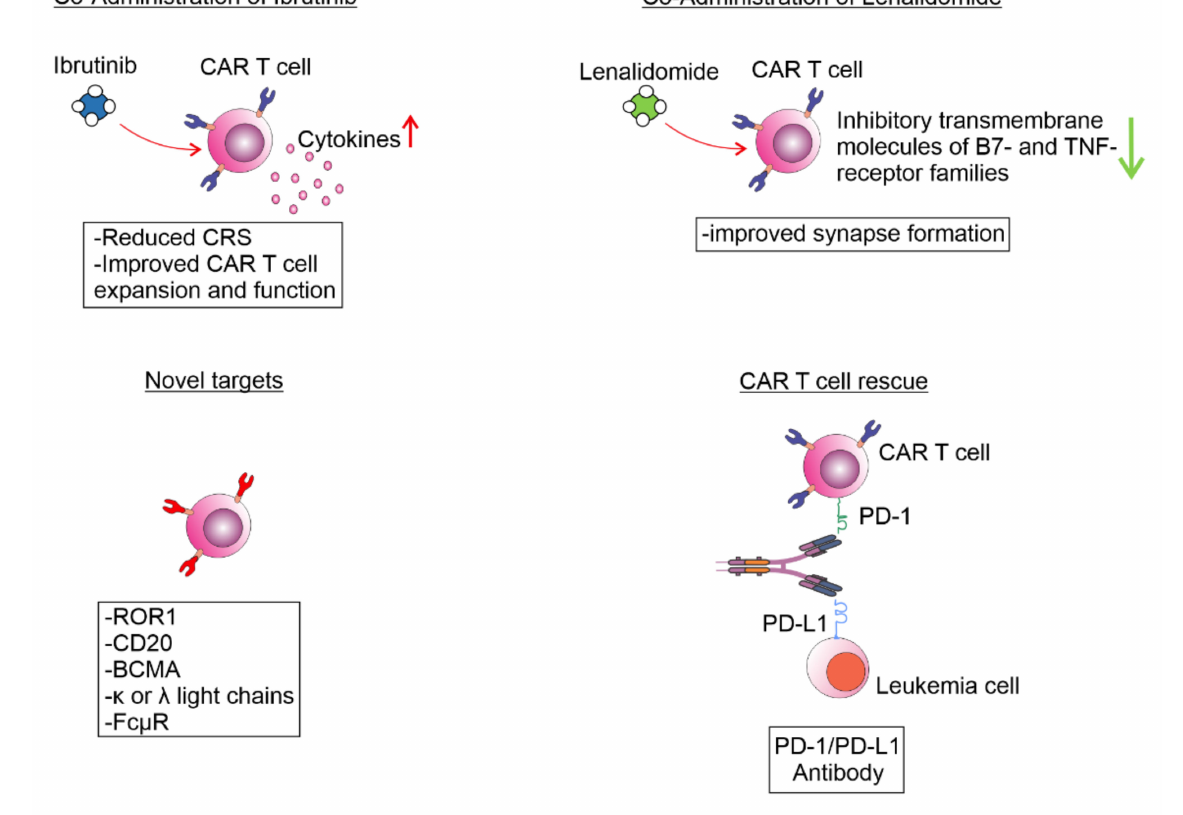
Figure 3. Novel attempts to improve CAR T cell therapy in